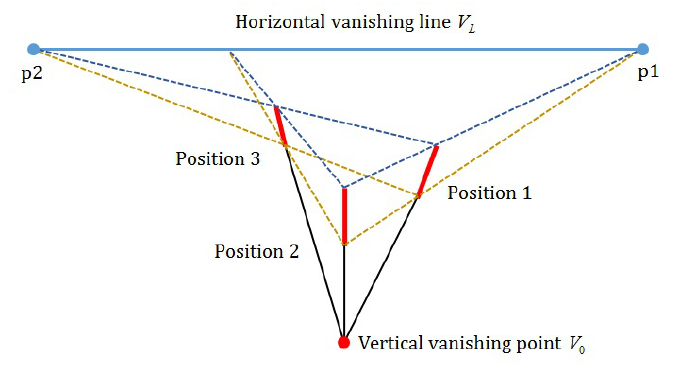
Figure 5. Estimation of vanishing lines and vanishing